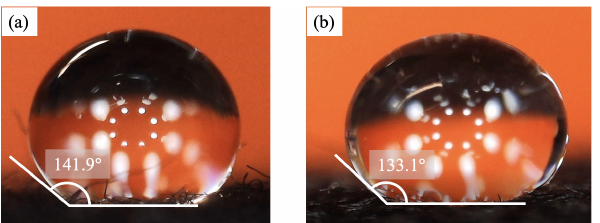
Figure 3. Scheme of the contact angles of the drops used to measure the wettability on top of the ( a ) CCF and ( b )